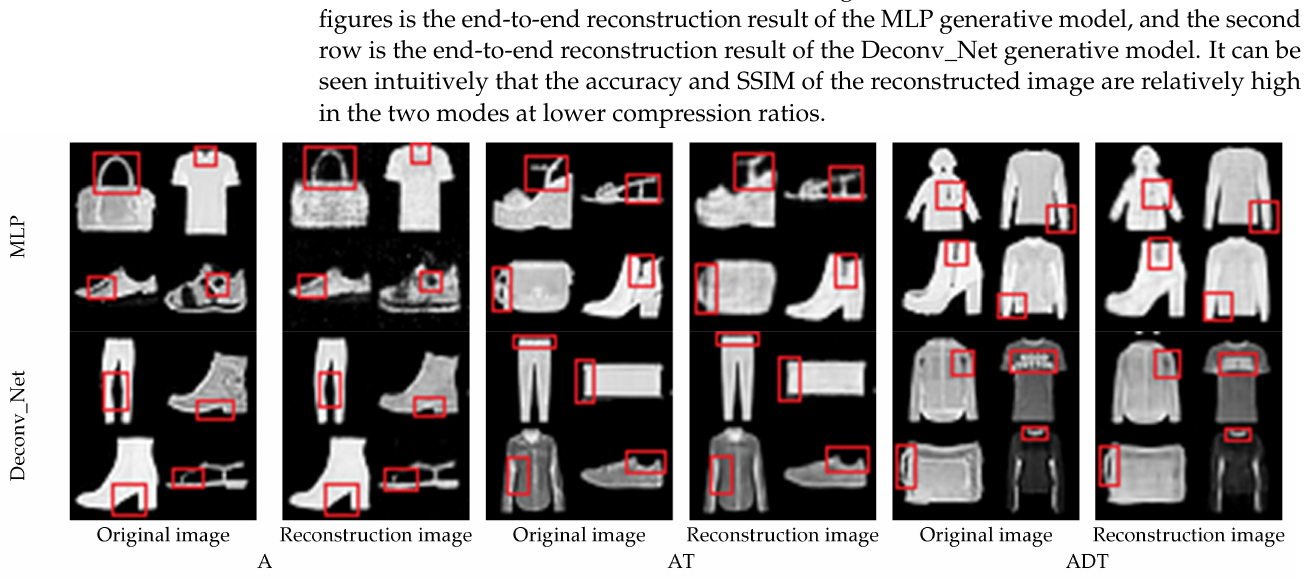
Figure 8. Reconstruction results of a 90% compression ratio.